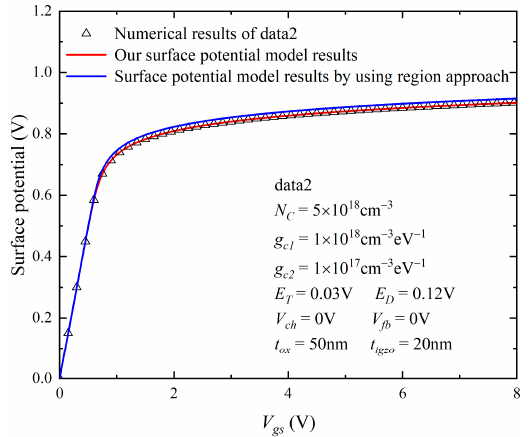
Figure 6. Comparisons of surface potential results between our model, regional approach and numerical results using data2.